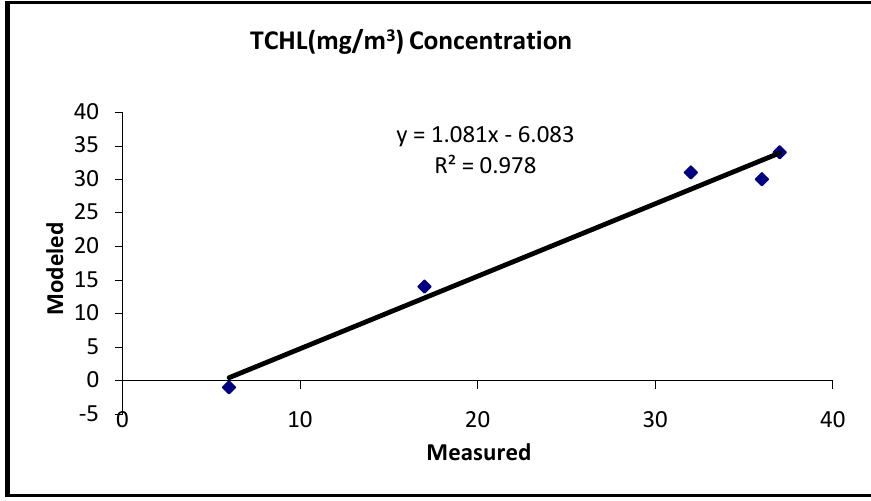
Figure 5. Trend line for the given values of measured and calculated chlorophyll